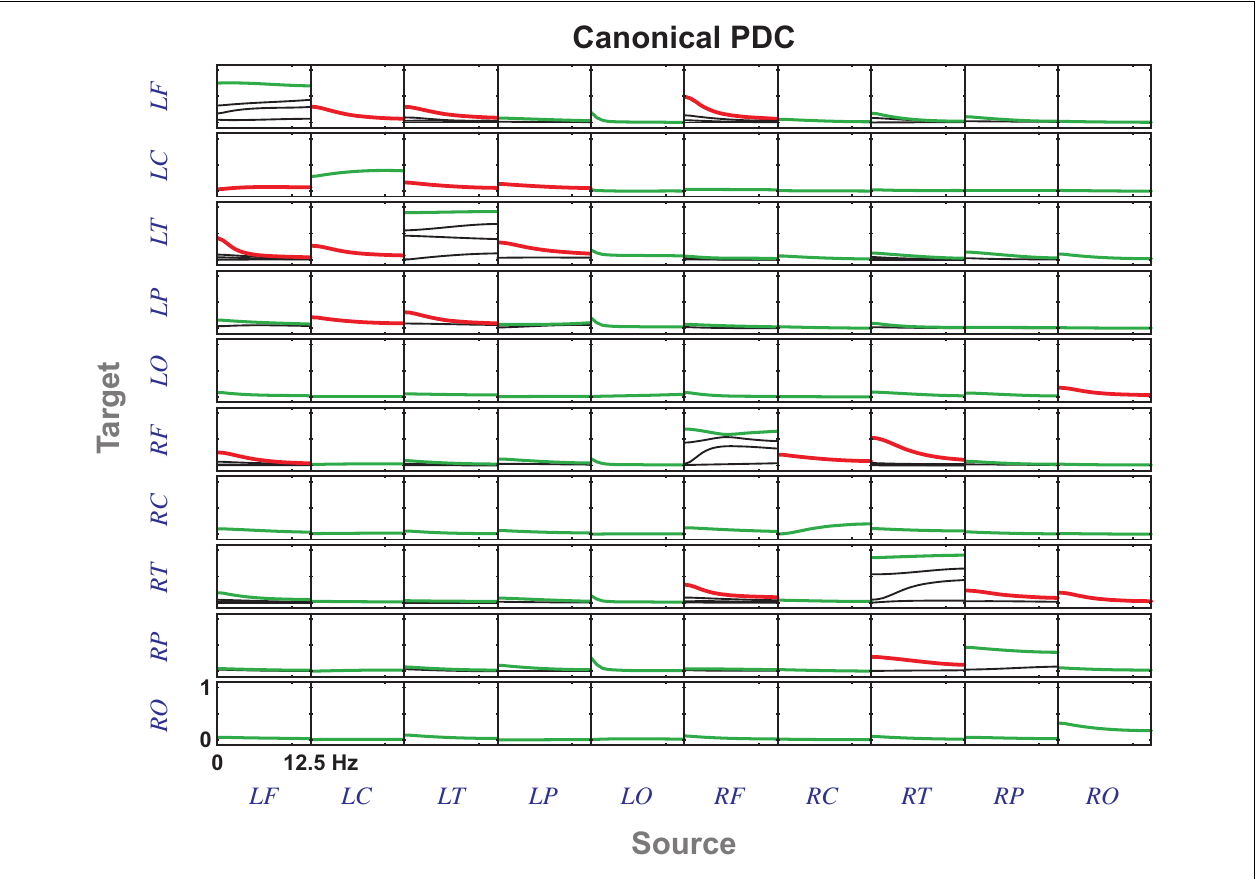
FIGURE 7 | cPDC from the Empirical Data example (section 5.2) from the left mesial ictal episode where the largest components are represented either in red or green. cPDC values in red were arbitrarily considered significant and were pictorially summarized in Figure 8B